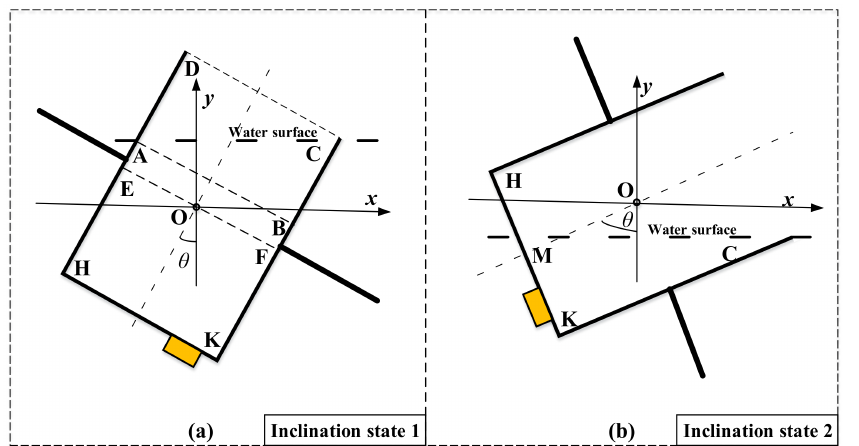
Figure 3. Different inclination situations of the hybrid design when it is flipped. ( a ) inclination state 1; ( b ) inclination state